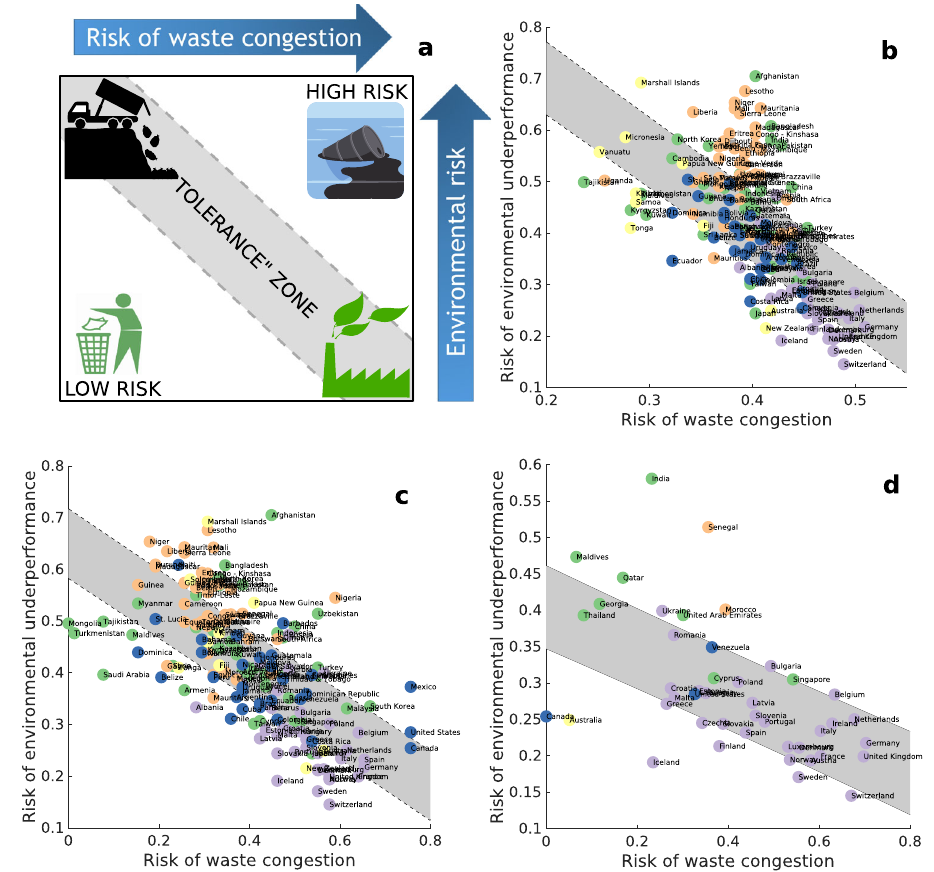
Fig. 2 Potential environmental impact of waste congestion (PEIWC). Plot of the risk of waste congestion versus the environmental performance ( a ) indicating the central region of “ tolerance ” where countries process waste with relatively low environmental and human health impacts. The tolerance zone is de fi ned here by the upper and lower 50% prediction bounds for response values associated with the linear regression trend between the two risk indices. Countries over the tolerance zone are at high risk of improper handling and disposal of wastes (HRIHDW). b – d Illustration of the PEIWC for wastes of types I – III, respectively. Nodes are colored by the continent to which the country belongs to: blue (Americas), purple (Europe), orange (Africa), green (Asia), yellow (Australia/Oceania). Icons of panel a were obtained from https://www.pdclipart.org/ under CC Public